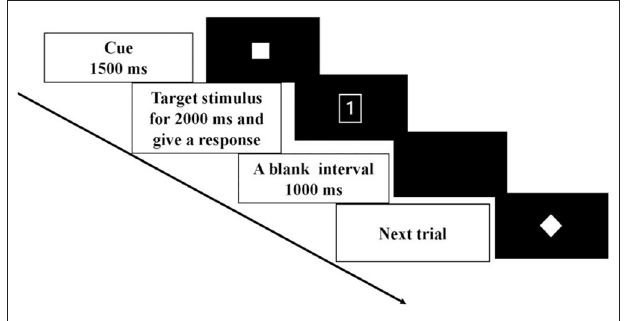
FIGURE 1 | Schematic illustration of the time course of one trial in a task-switching